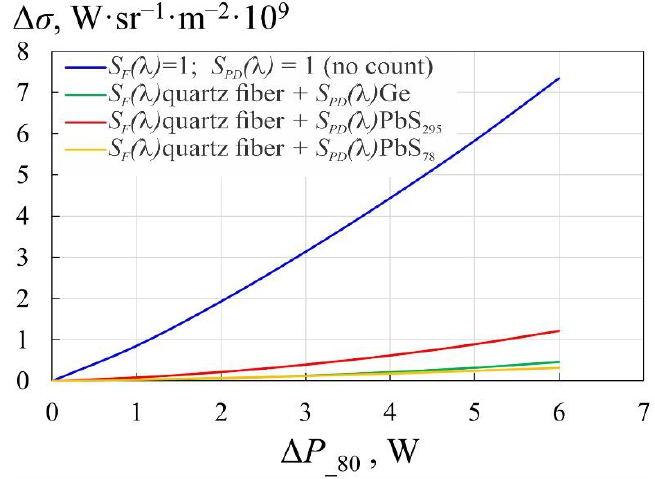
Figure 10. The dependence of the spectral density of radiation TOTFC ∆ σ from ∆ P _80 without taking into account S F ( λ ) and S PD ( λ ) and considering S F ( λ ) and S PD ( λ ) for varied PD (the wavelength of laser radiation is 980 nm, the inner vein diameter is 5 mm).